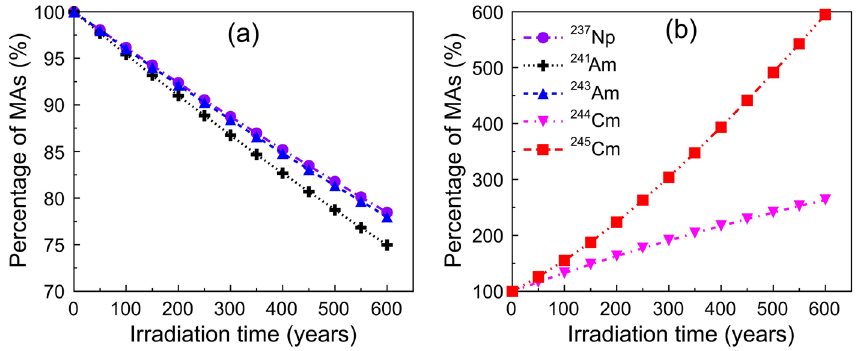
Figure 6. Percentage of MAs remaining in the core over one 600-day cycle. The transmutation percentages for 237 Np, 241 Am and 243 Am are positive ( a ), and the values for 244 Cm and 245 Cm are negative ( b ).